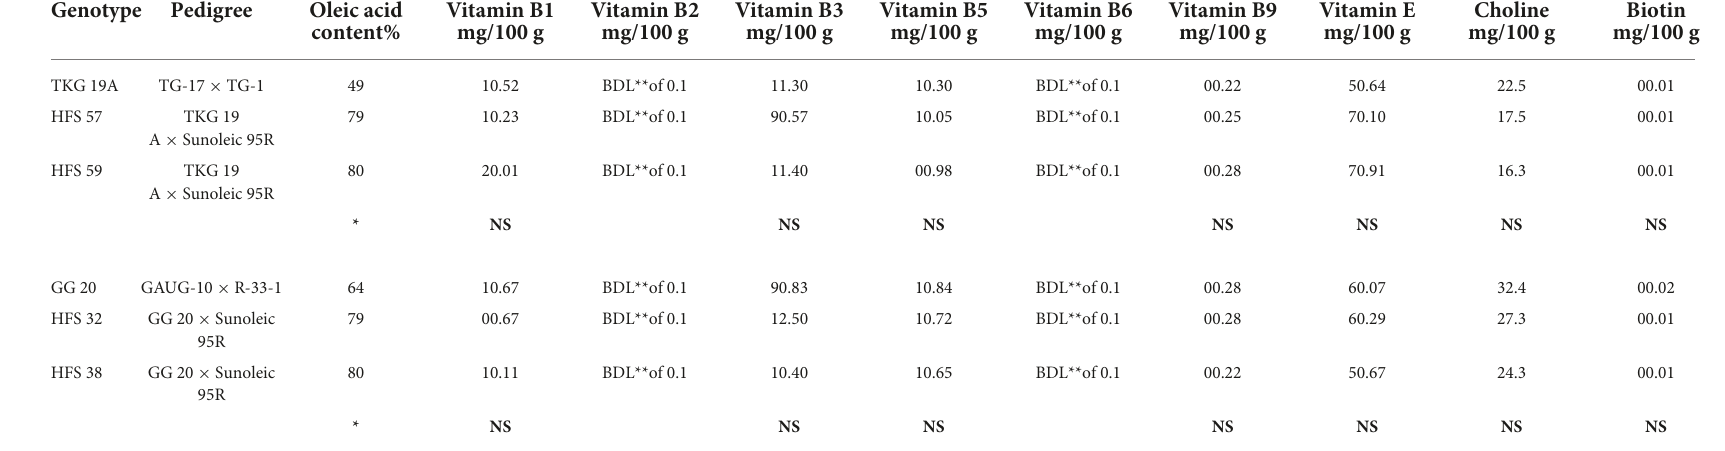
TABLE 10 Vitamin compositions in the seeds of normal oleic groundnut varieties and their high oleic content breeding lines.